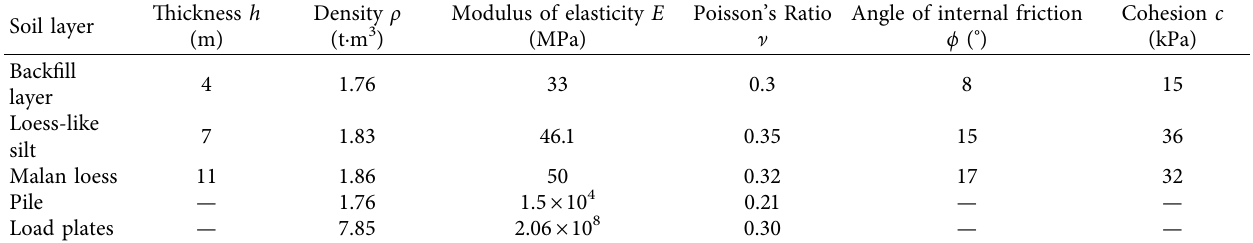
Table 8: Model material parameters.